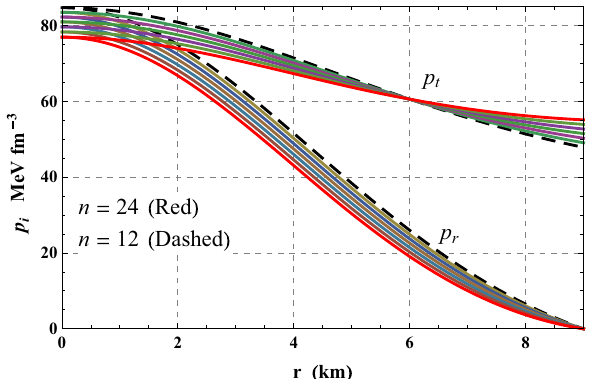
Fig. 3 Variation of pressure with radial coordinate for the parameters given in Table 1